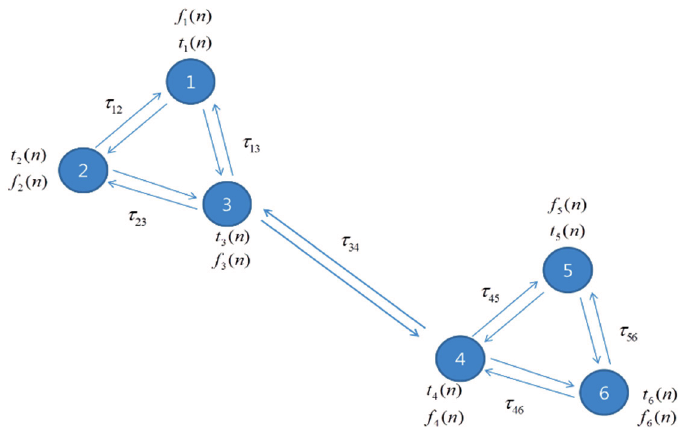
Figure 6. Multi-hop network topology used in the simulation.